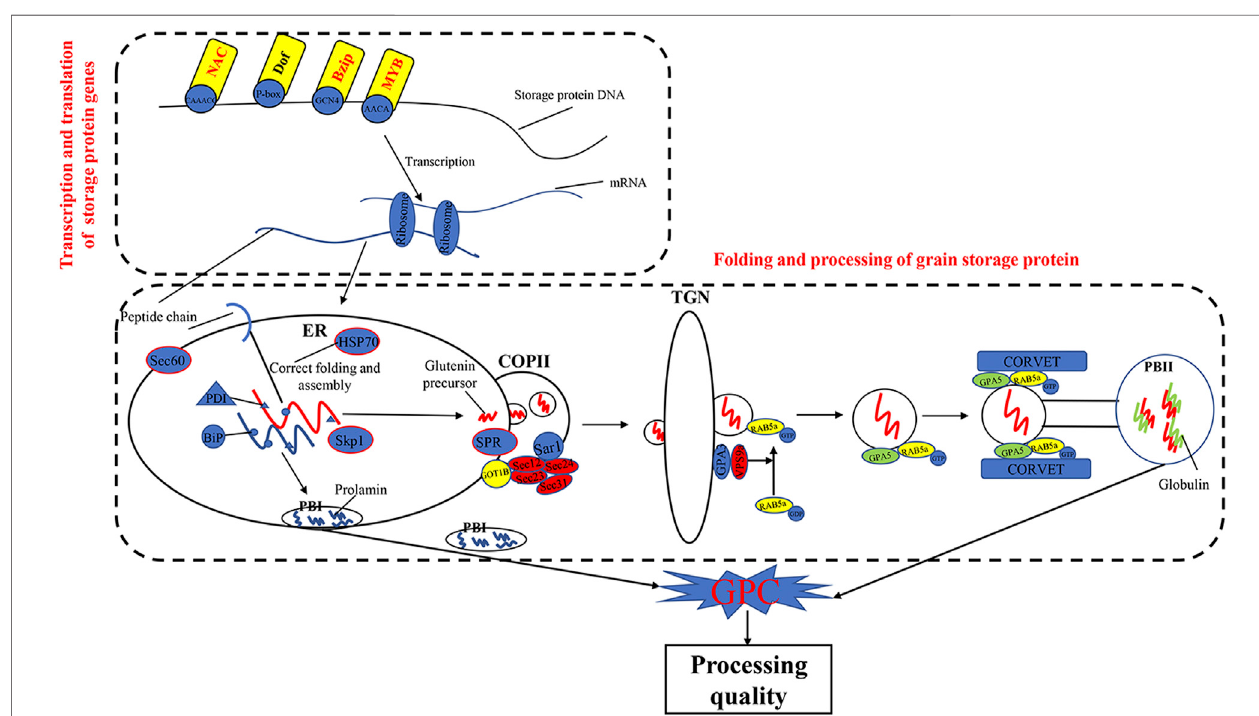
Frontiers in Genetics |